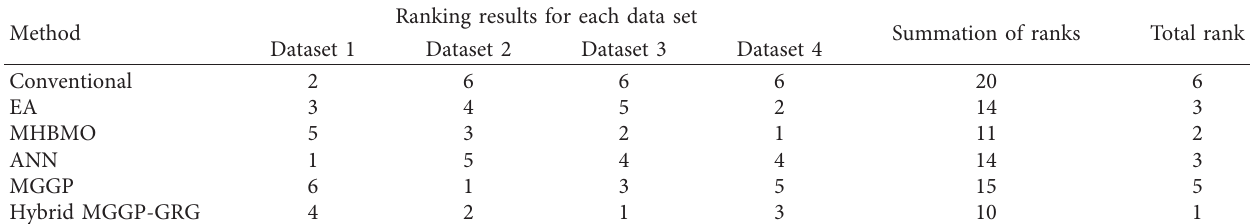
Table 6: Ranking the performances of different methods for developing single-value rating